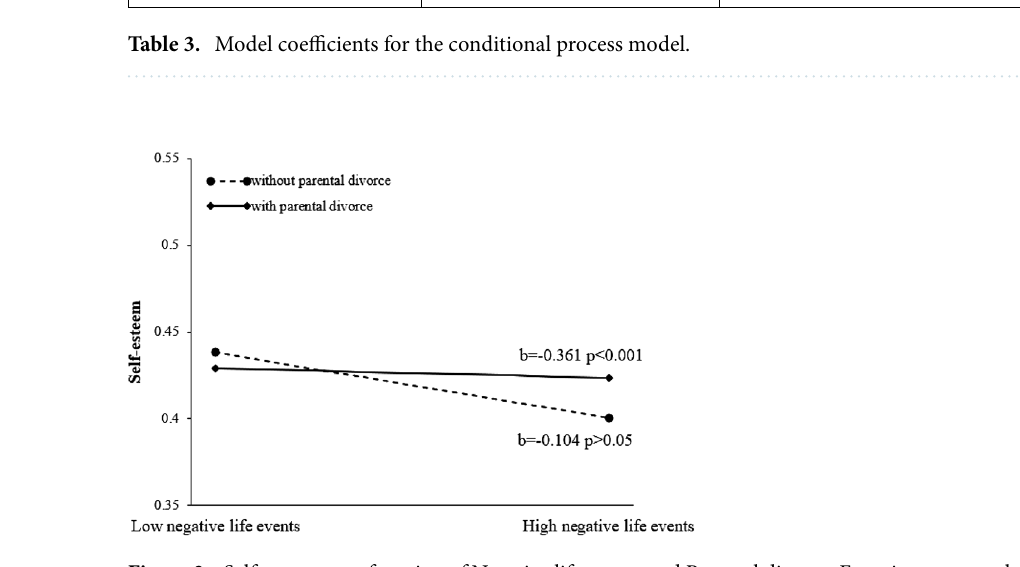
Figure 3. Self-esteem as a function of Negative life events and Parental divorce. Functions are graphed for two conditions: with parental divorce and without parental